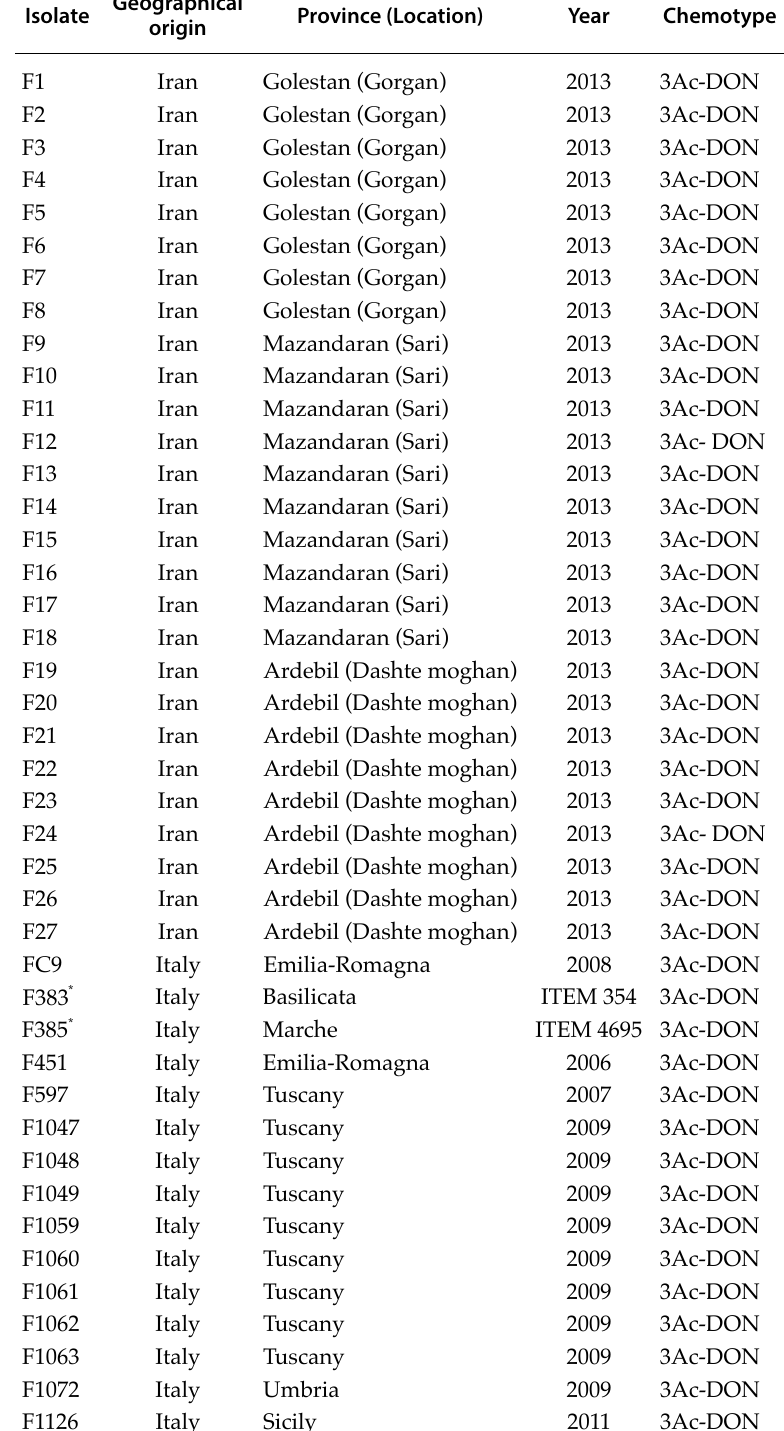
Table 1. Origins of 27 Fusarium culmorum isolates from three Provinces of Iran, obtained from infected wheat crown tissues, and isolates from Italy. Their chemotypes (determined by PCR assays) are also